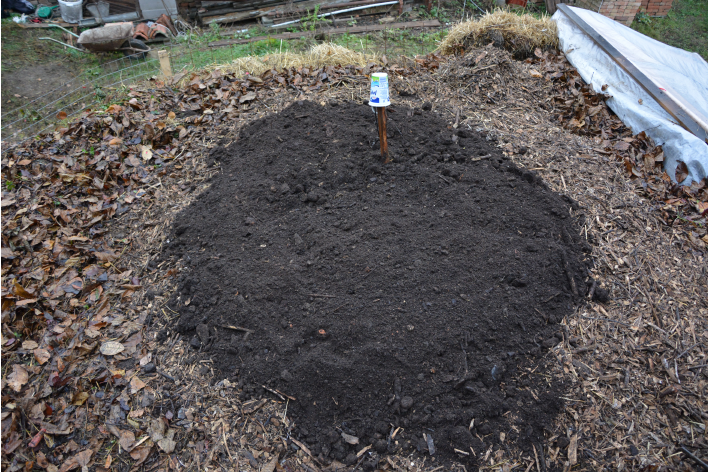
Figure 12. A compost biofilter cover layer of about 20–30 cm is applied on top of the permeable layer covering the heat